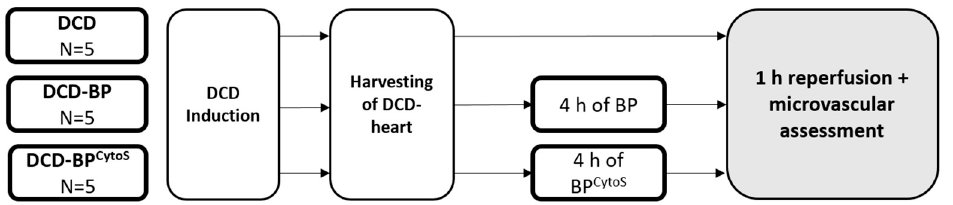
Figure 1. Workflow. BP: blood perfusion. DCD: donation after circulatory death. BP CytoS : blood perfusion with an integrated cytokine adsorption device.